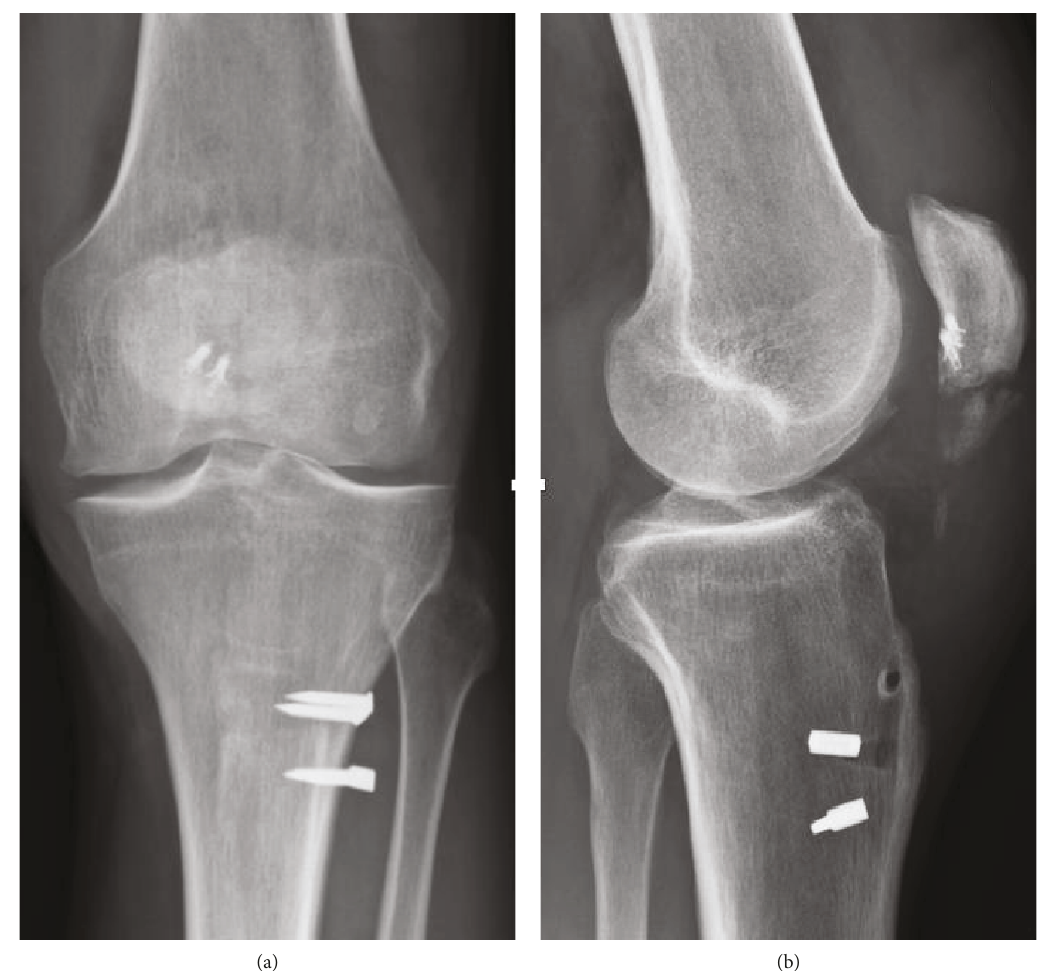
Figure 4: (a) Anteroposterior and (b) sagittal postoperative X-rays at 3